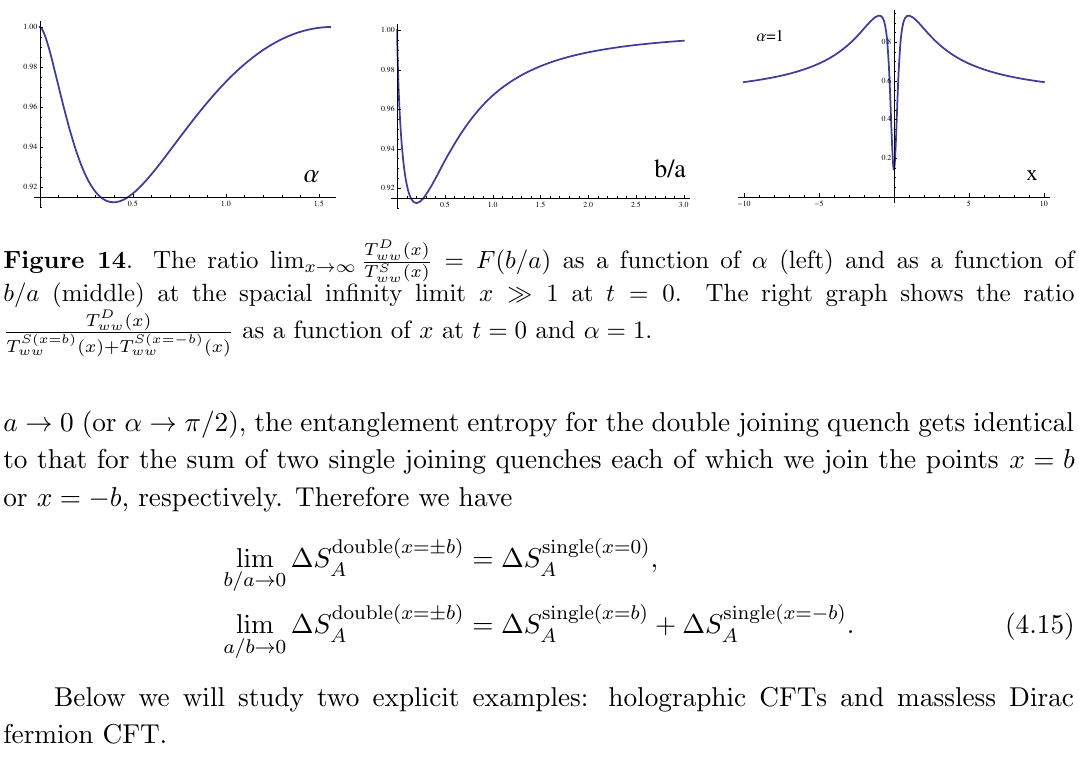
T D ww ( x ) = F ( b=a ) as a function of (cid:11) (left) and as a function of x T S ww ( x ) !1 1 at t = 0. The right graph shows the ratio (cid:29)